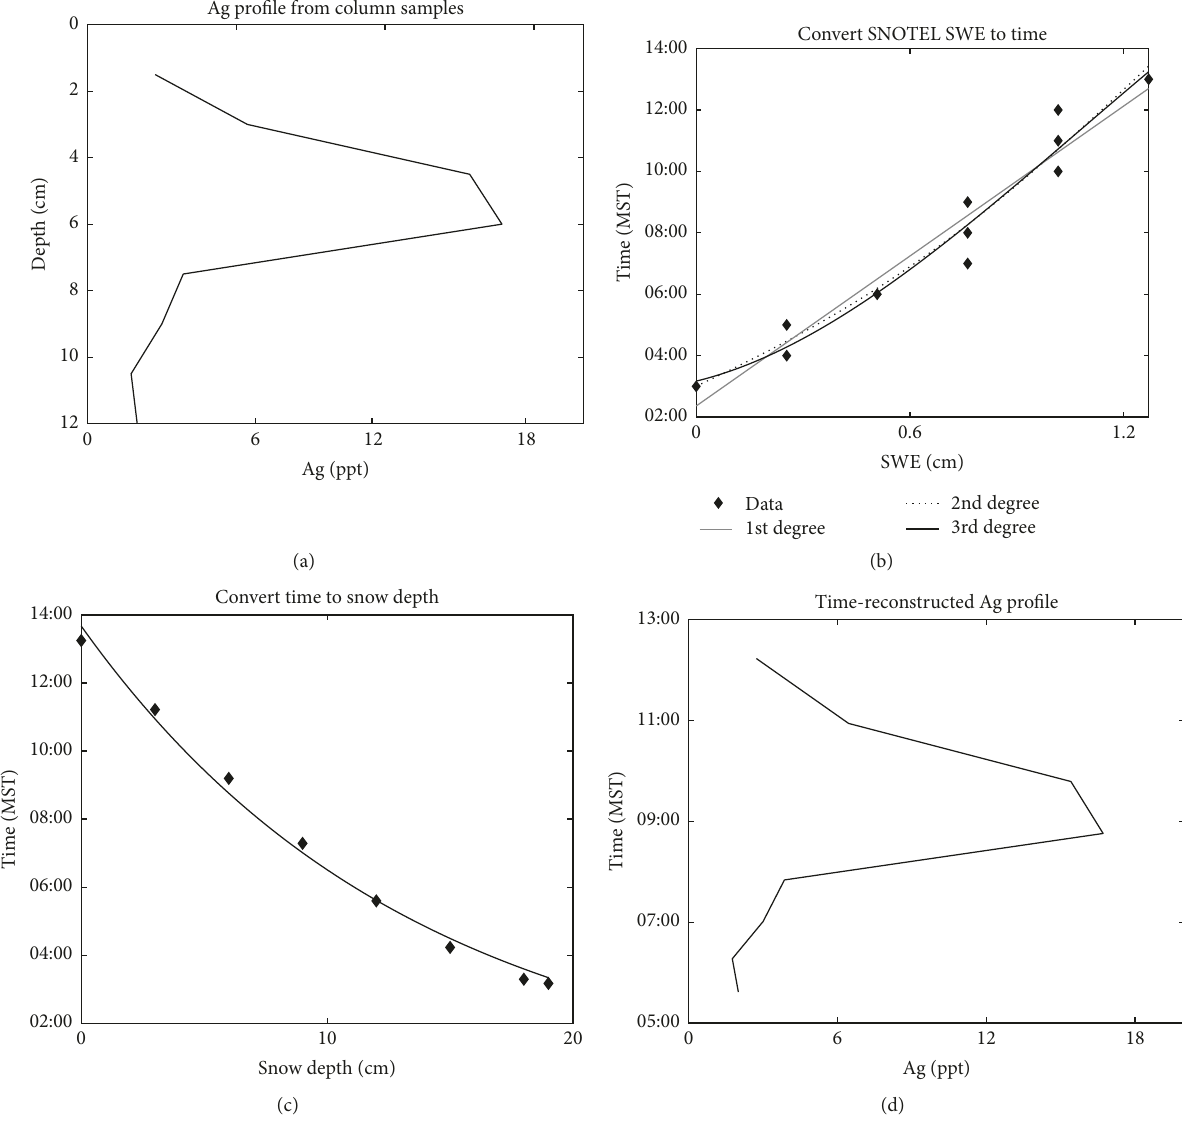
Figure 2: (a) Typical column sample profile, collected at 1.5 cm resolution. (b) Time and SWE from a SNOTEL station nearest to the snow pit collected in plot (a). 1st-, 2nd-, and 3rd-degree polynomials model these relationships. (c) Depth in the snow pit related to time from plot (b). (d) Time-reconstructed Ag profile. Table 3: Observed seeding signatures for ground and areal-based events. Snow pits sampled in the target zone G A A + G Seeded snow pits sampled